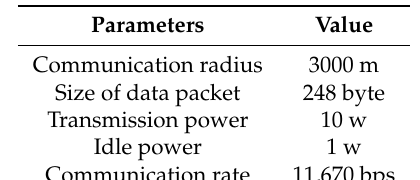
Table 3. Simulation parameters [26].